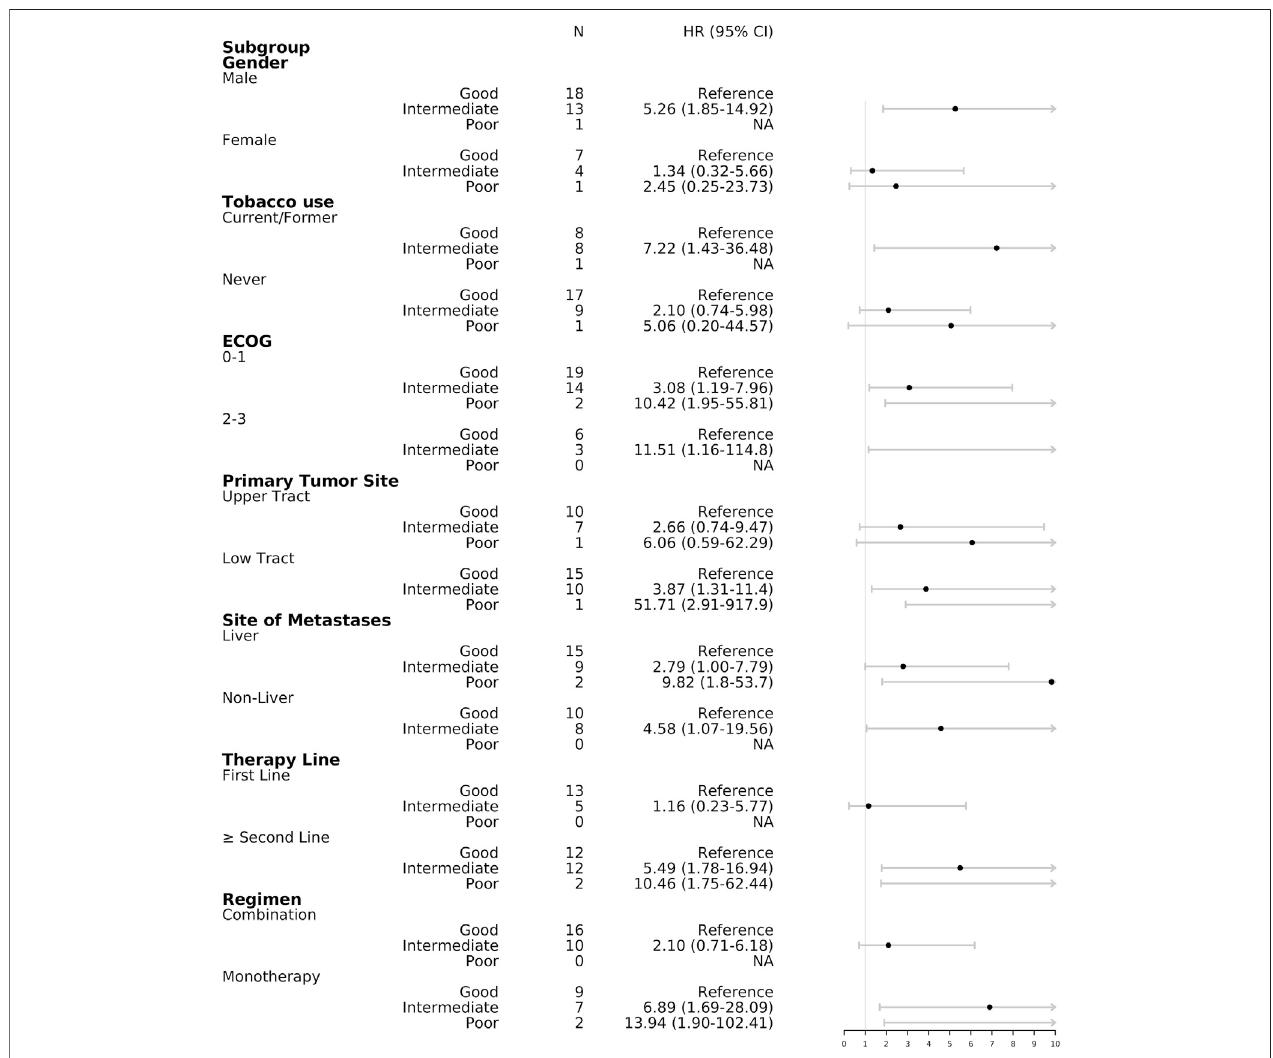
FIGURE 3 | Forest plot of hazard ratios in the subgroup analysis comparing progression-free survival of mUIPI.